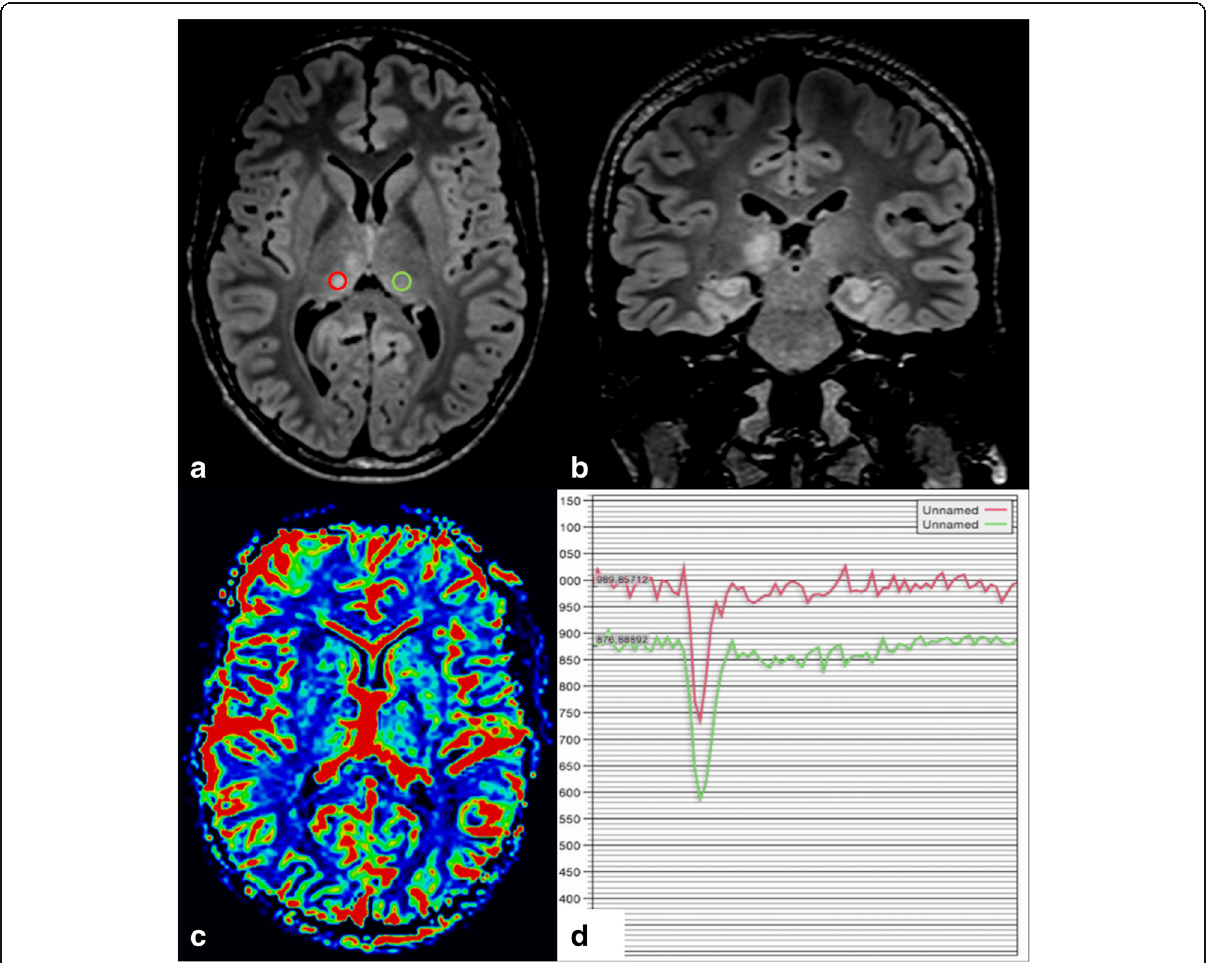
Fig. 8 Bright confluent foci in the right thalamus on axial and coronal ( a , b ) FLAIR, not associated with mass effect or surrounding oedema. Absence of hypervascularisation on perfusion MR ( b , c ) further confirms the benign nature of these lesions allowing differentiation between primary brain tumour such as astrocytoma or glioblastoma and benign lesions. These are FASIs of a patient with